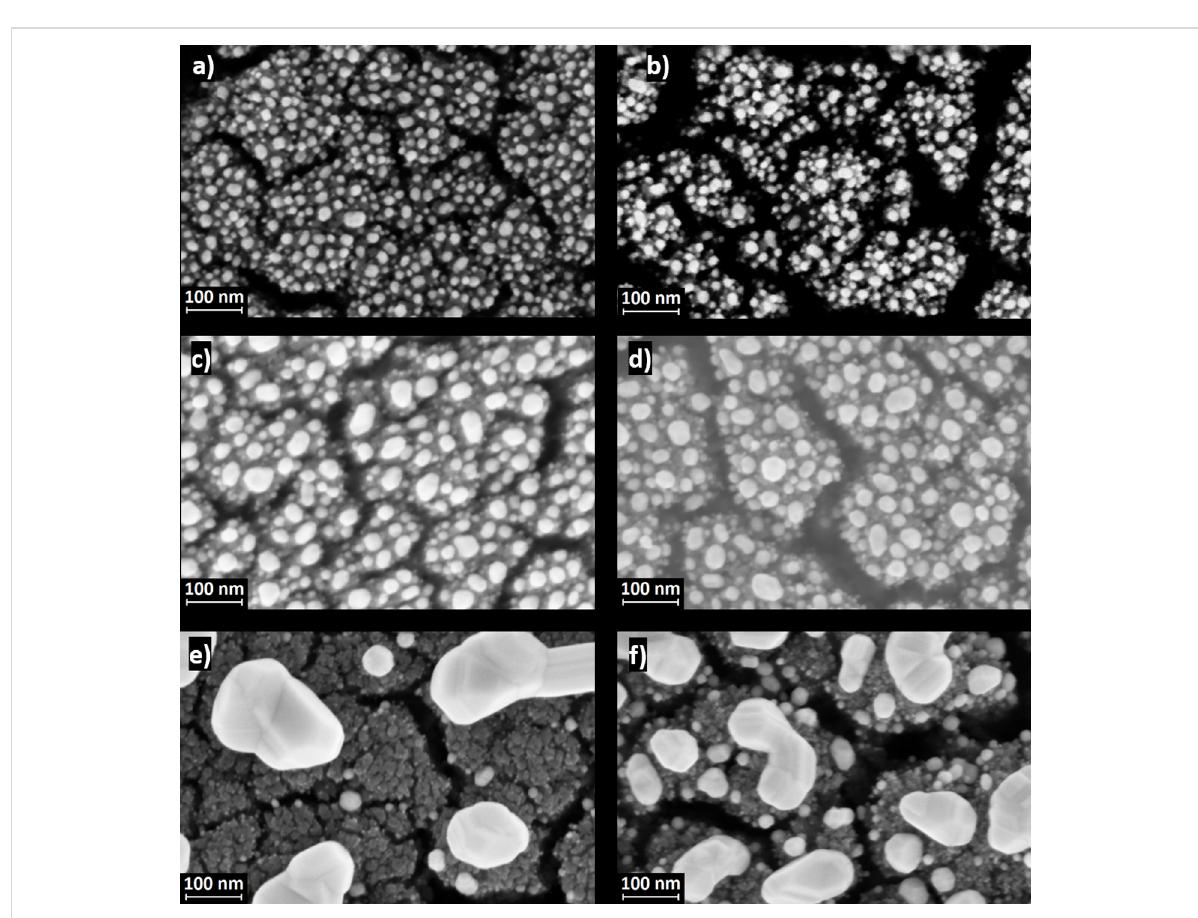
Figure 3: SEM top-view images of TiO 2 8 Pa with 3 nm (a), 6 nm (c), and 15 nm (e) of Au, and of TiO 2 12 Pa with 3 nm (b), 6 nm (d), and 15 nm (f) of Au. All micrographs were acquired after